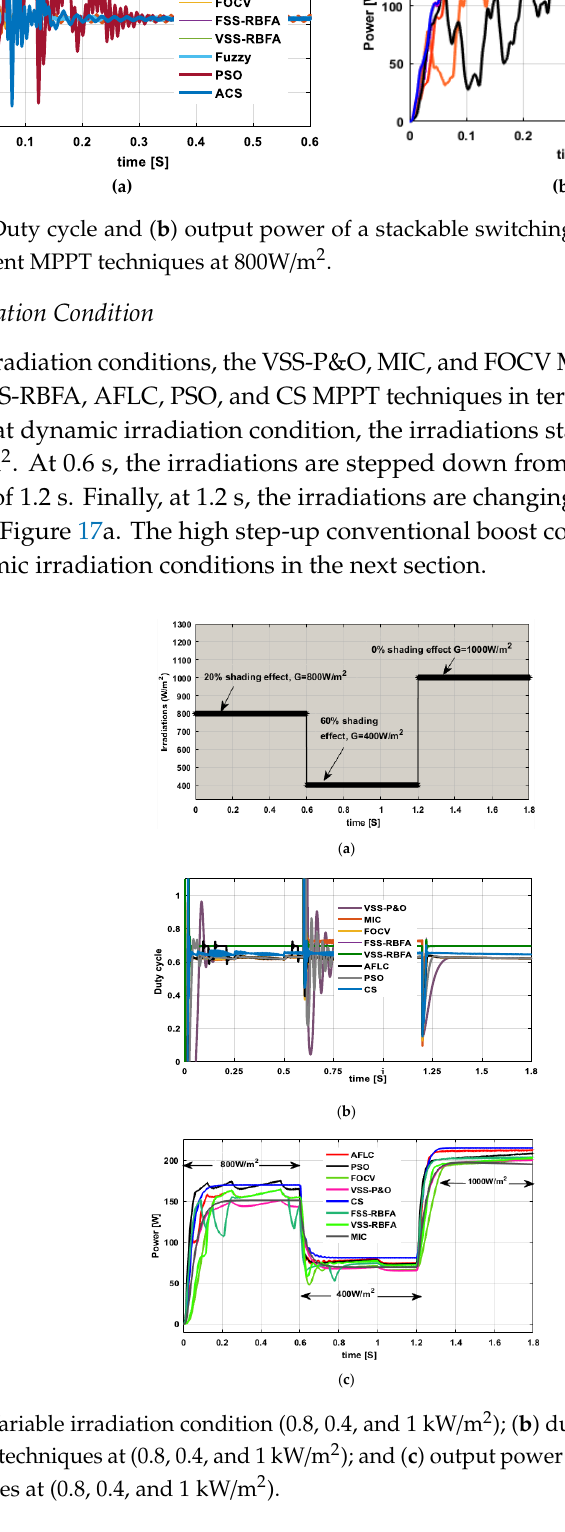
(b) Figure 15. ( a ) Duty cycle and ( b ) output power of a switched capacitor boost converter (SCBC) by applying different MPPT techniques at 800W/m 2 . 6.1.3. Stackable Switching Boost Converter at 800 W/m 2 From Figure 16a, the VSS-RBFA-based MPPT technique extracts the maximum PV power of